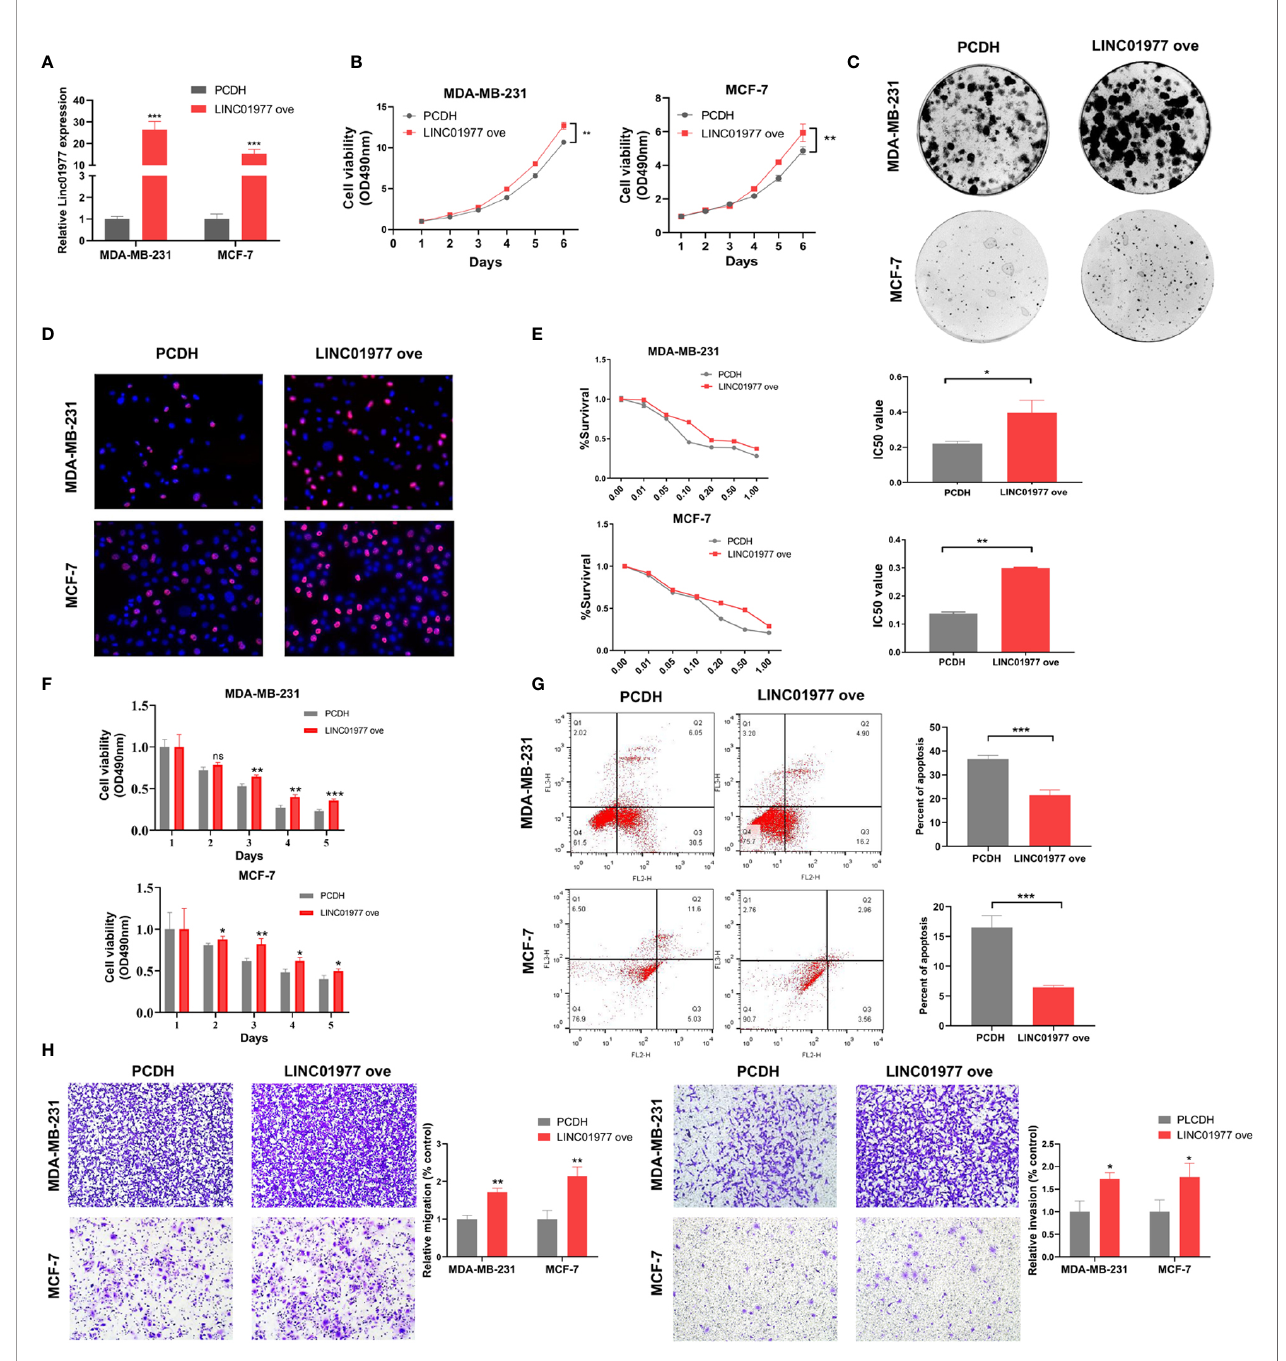
FIGURE 3 | LINC01977 overexpression promoted breast cancer cell proliferation, metastasis, and chemoresistance to DOX. (A) The ef fi ciency of LINC01977 expression was evaluated by real-time PCR in MDA-MB-231 and MCF-7 cells. (B) MTT assay. (C) Colony formation assay. (D) EDU assay. (E) IC50. (F) Cytotoxicity assay. (G) Apoptosis assays. As shown in right panel, total apoptosis cells were quanti fi ed. (H) Transwell assay. Left panel: Cell migration assay. Right panel: Cell invasion assay. PCDH: empty PCDH vector using as negative control. (*p < 0.05, **p < 0.01, ***p < 0.001, ****p < 0.0001; Student ’ s